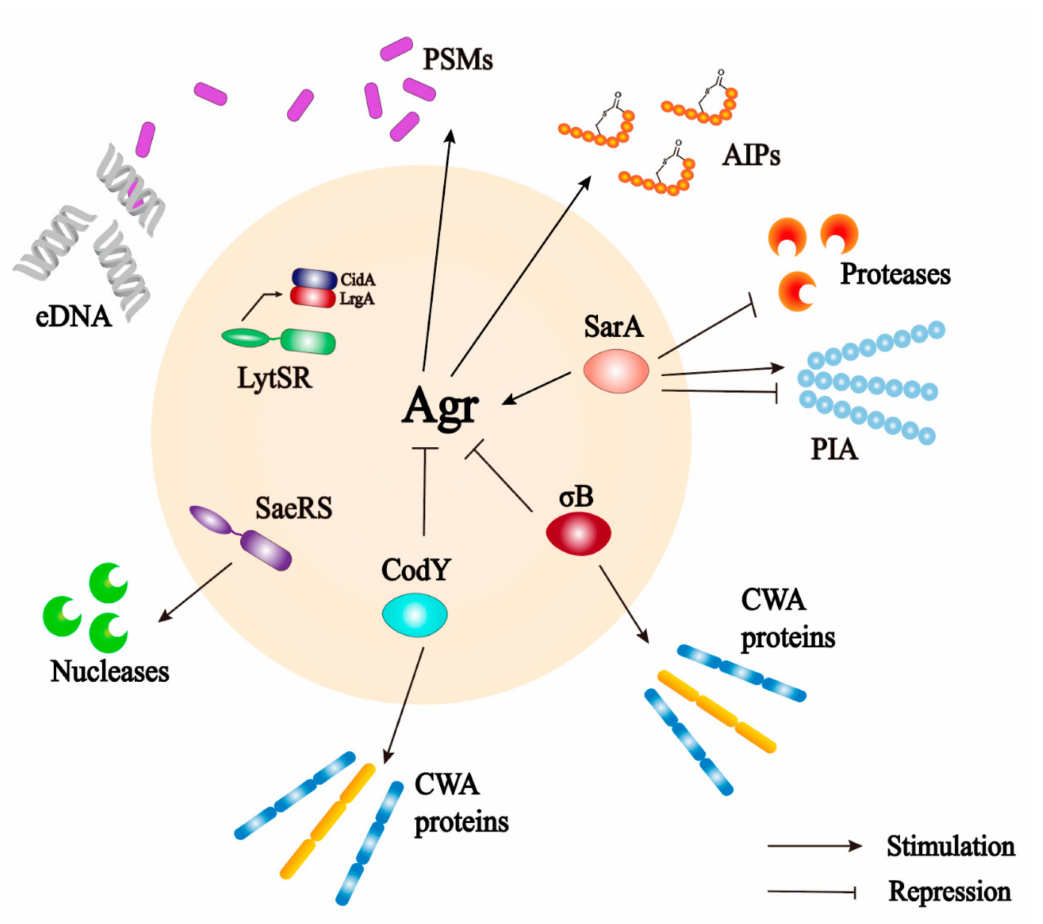
Figure 5. The interaction between Agr quorum sensing system and some important biofilms regula- tors (LytSR TCS, SigB, CodY and SarA)